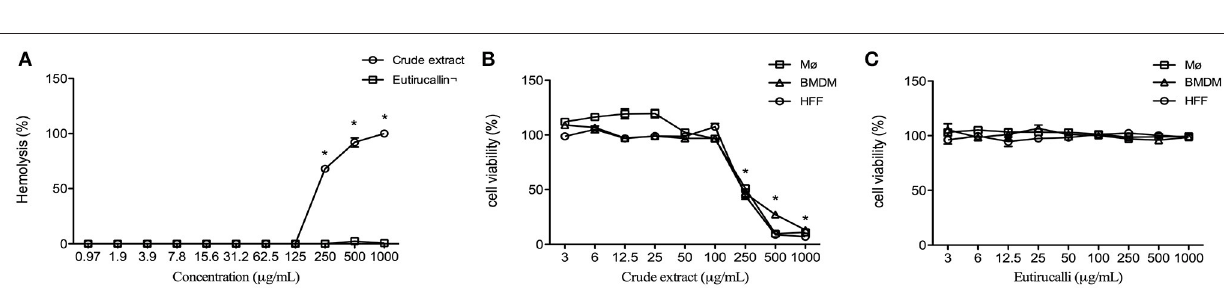
Frontiers in Cellular and Infection Microbiology |